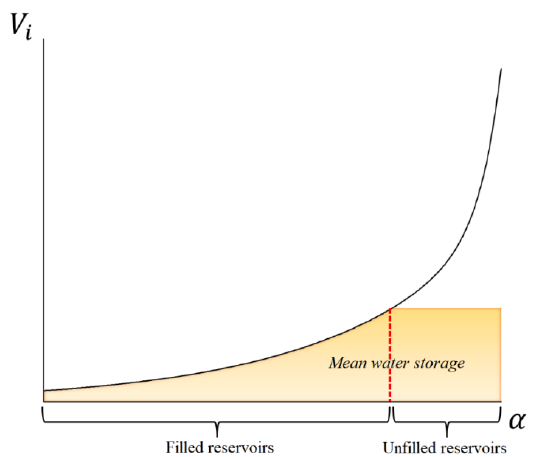
Figure 2. A schematic illustration of the capacity cumulative distribution function (black curve). The shaded area is the mean water storage of small reservoirs in a sub-basin and can be used to determine the proportion of unfilled and filled reservoirs in this sub-basin.